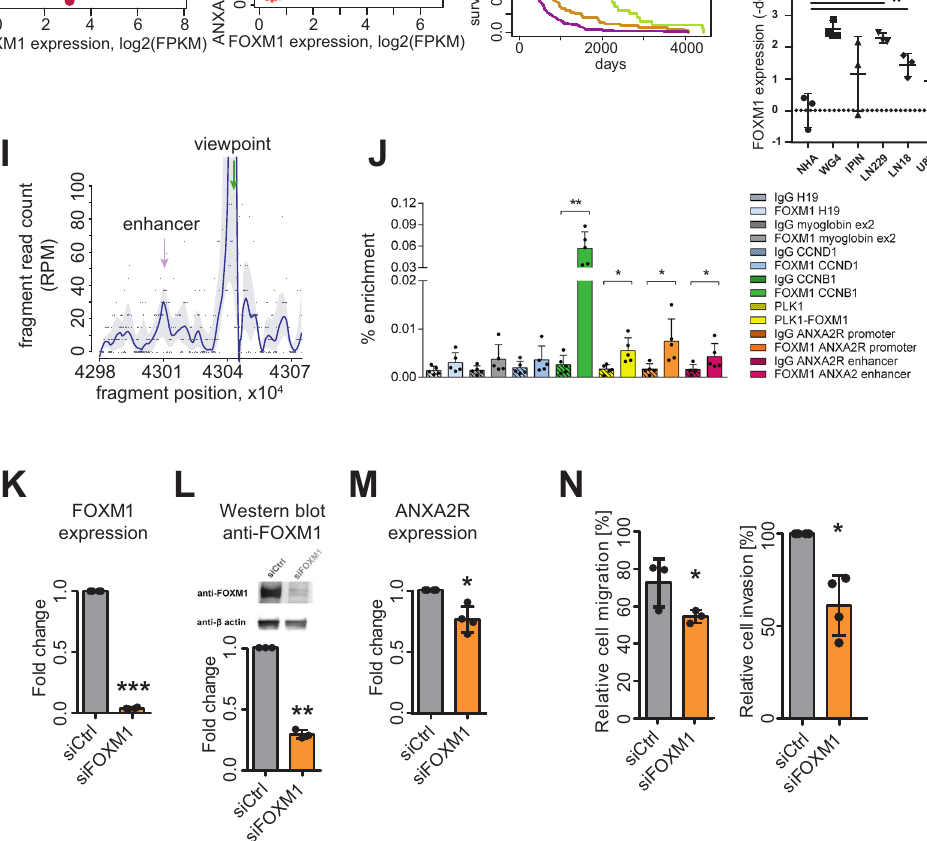
practices, and only datasets passing stringent quality control metrics are presented. For each protocol, the average coverages (normalized read depth in millions [M]) were as follows: for ATAC-seq — 76.9 M ( n = 8), K3K4me3 — 12.3M ( n = 24), H3K27ac — 18.7 M ( n = 16), H3K27me3 — 41.7M ( n = 12), RNAseq — 50M, 25 M per end pairs ( n = 24), DNA methylation seq 106 M ( n = 24). Key resources uti- lized during the experiments and data analysis are listed in Supplementary Table 5.